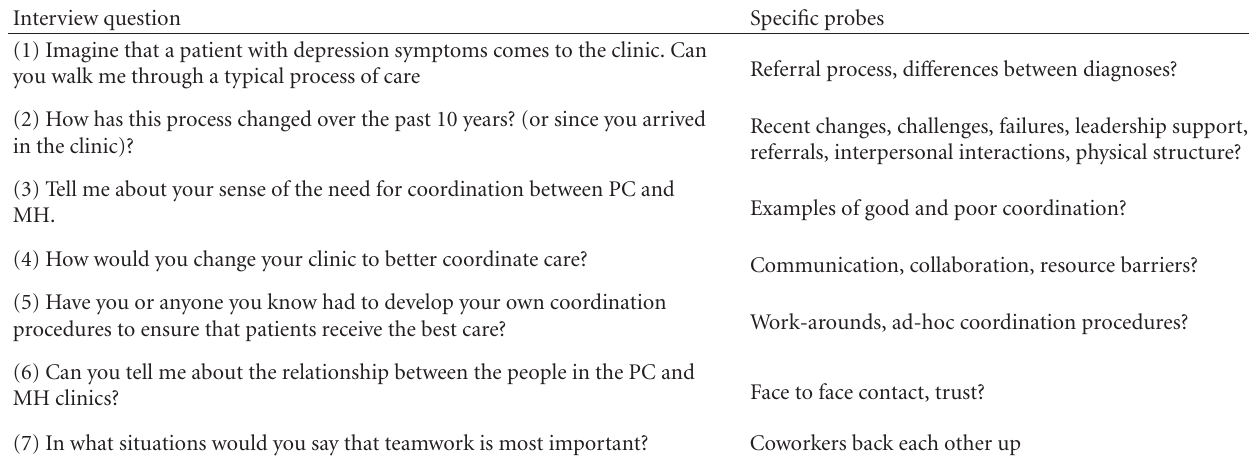
Table 1: Interview questions and specific probes.